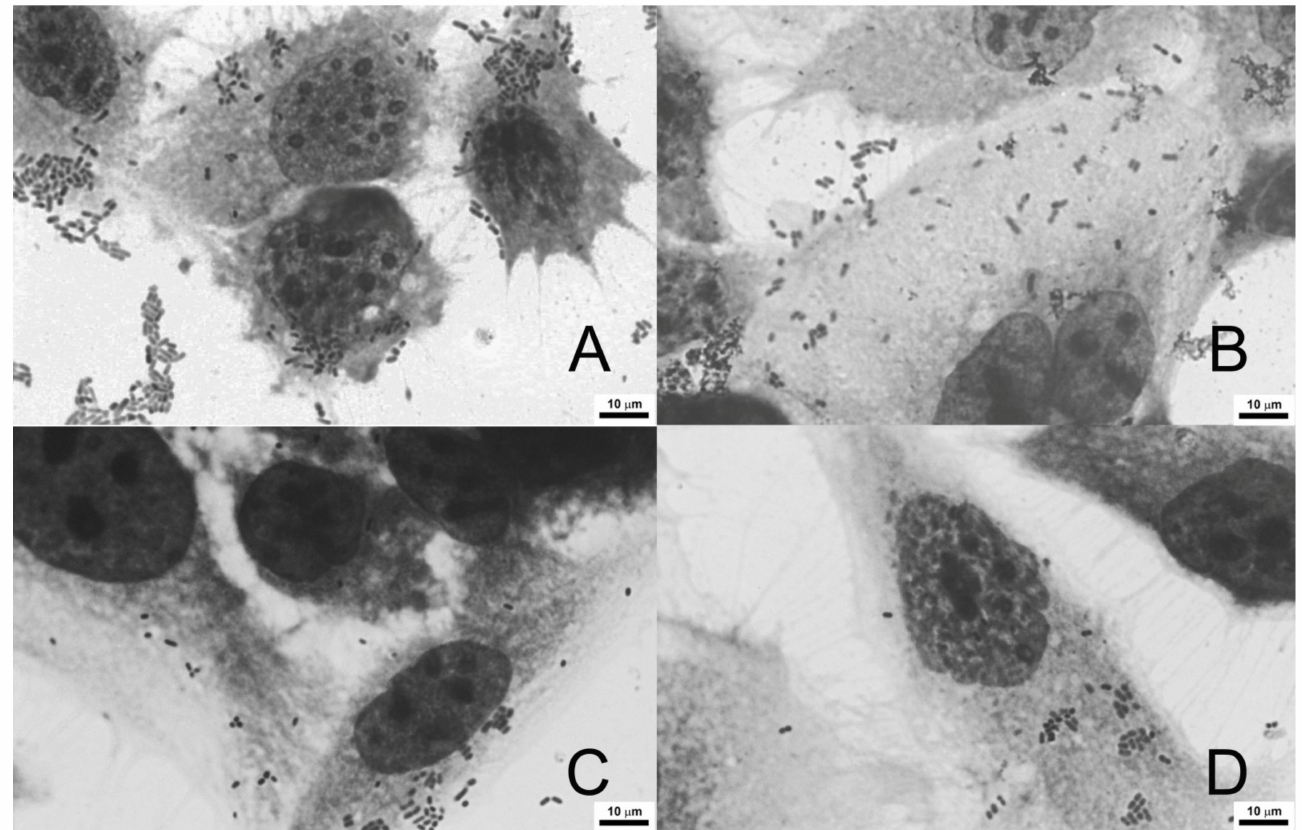
Figure 8. Adherence of E. coli (LF82 strain) to Caco-2 cells. Representative pictures of bacteria adhering to untreated Caco-2 cells ( A ), and treated with PC at concentration of 0.125 mg/mL ( B ), 0.25 mg/mL ( C ), and 0.5 mg/mL, ( D ). Wright-Giemsa stain, 100 × magnification.